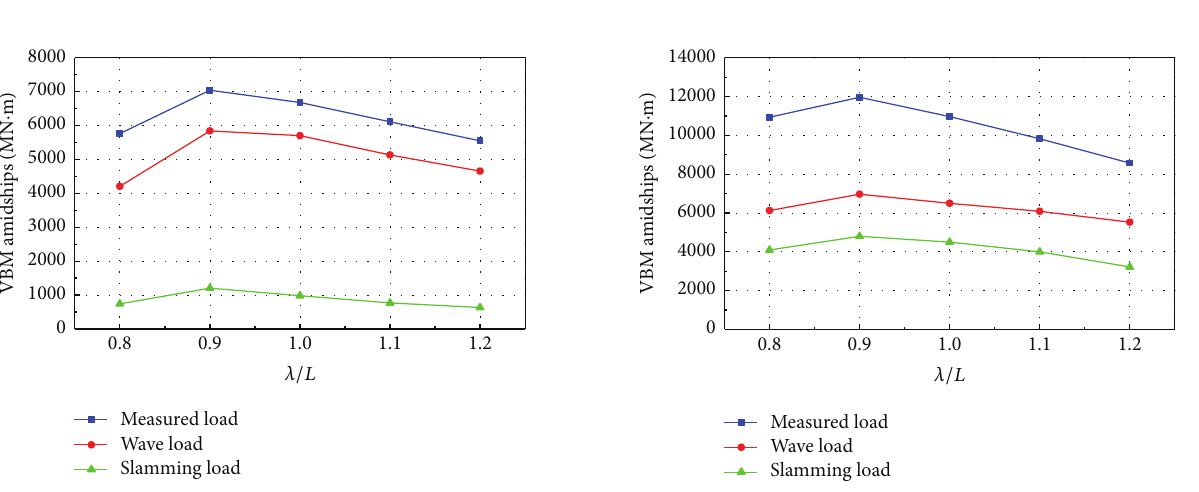
Figure 13: VBM amidships at different 𝜆/𝐿 of 5 knots (scheme 2). Figure 14: VBM amidships at different 𝜆/𝐿 of 18 knots (scheme